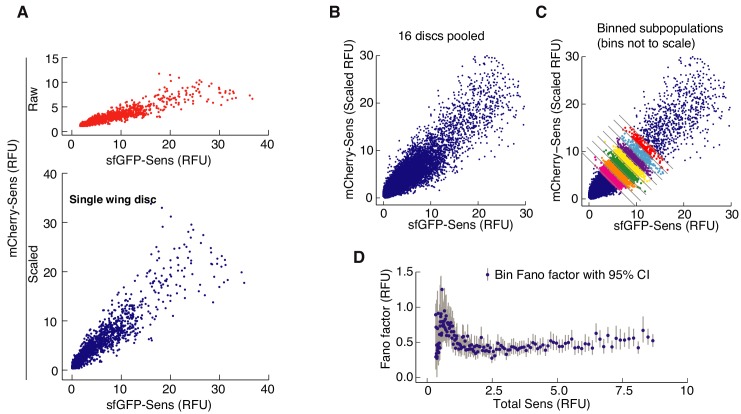
Fano factor calculation from nuclear fluorescence signals of Sens positive cells.(A) The mCherry signal intensity is scaled relative to sfGFP signal in Sens-positive cells from individual discs. (B) Data from discs of the same genotype are pooled together. (C) Pooled data are sorted into separate bins according to total Sens output. The intrinsic noise and mean for Sens is calculated for each binned sub-population. (D) The Fano factor of each bin is plotted as a function of mean Sens output in a bin. 95% confidence intervals for the estimated Fano factor are calculated by bootstrapping with resampling within each binned sub- population.